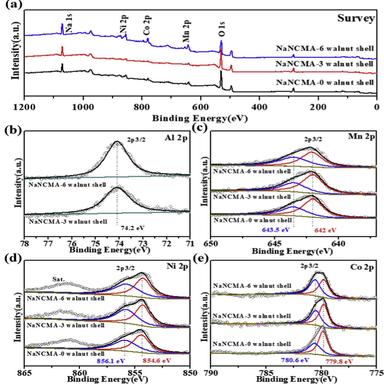
(a) X-ray Photoelectron Spectroscopy (XPS) survey spectra and the high-resolution XPS spectra of (b) Al 2p, (c) Mn 2p, (d) Ni 2p and (e) Co 2p for walnut-shell-like NaNCMA-0. NaNCMA-3 and NaNCMA-6 samples.